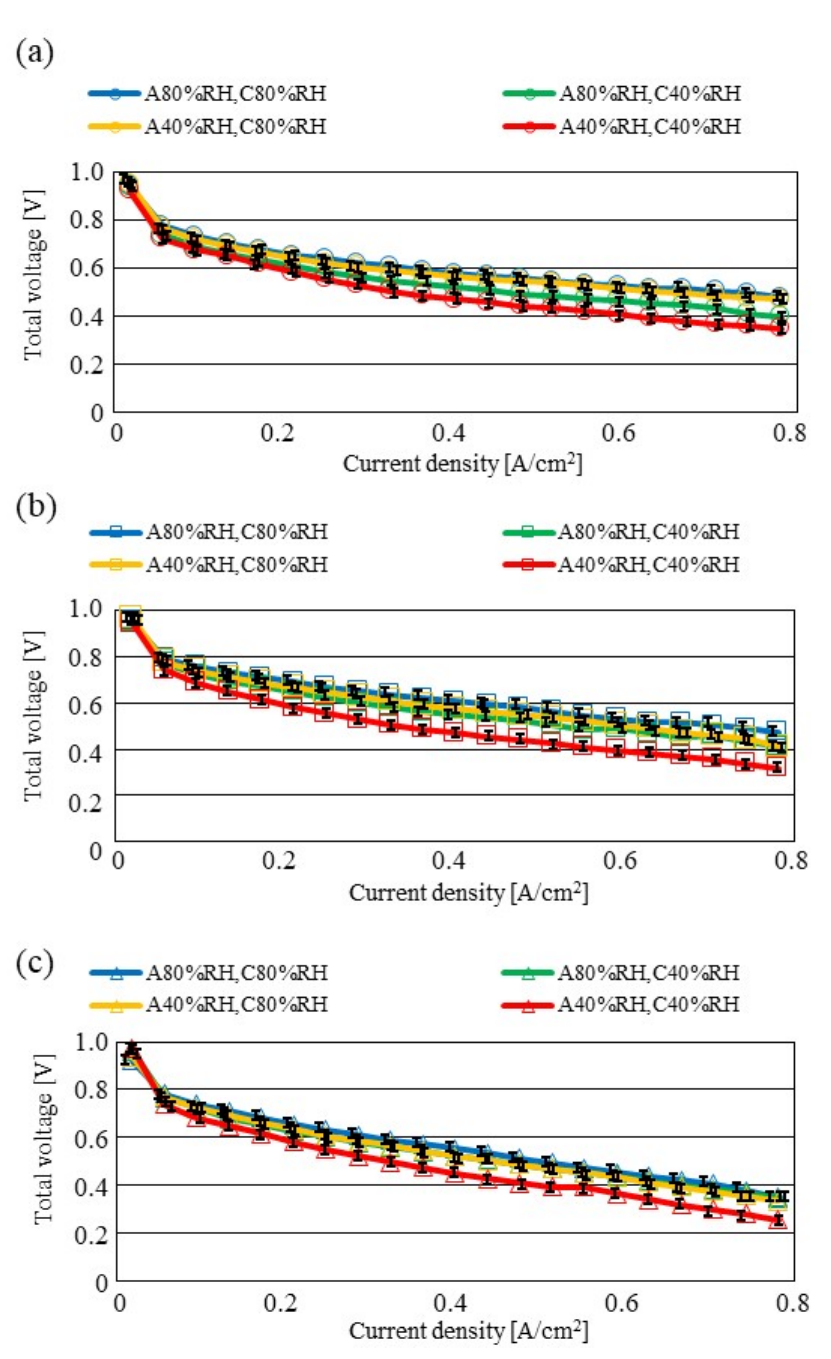
Figure 5. Comparison of polarization curves among different RHs for a separator thickness of 1.5 mm: ( a ) T init = 353 K; ( b ) T init = 363 K; ( c ) T init = 373 K. A80%RH&C80%RH, A80%RH&C40%RH, A40%RH&C80%RH and A40%RH&C40%RH were